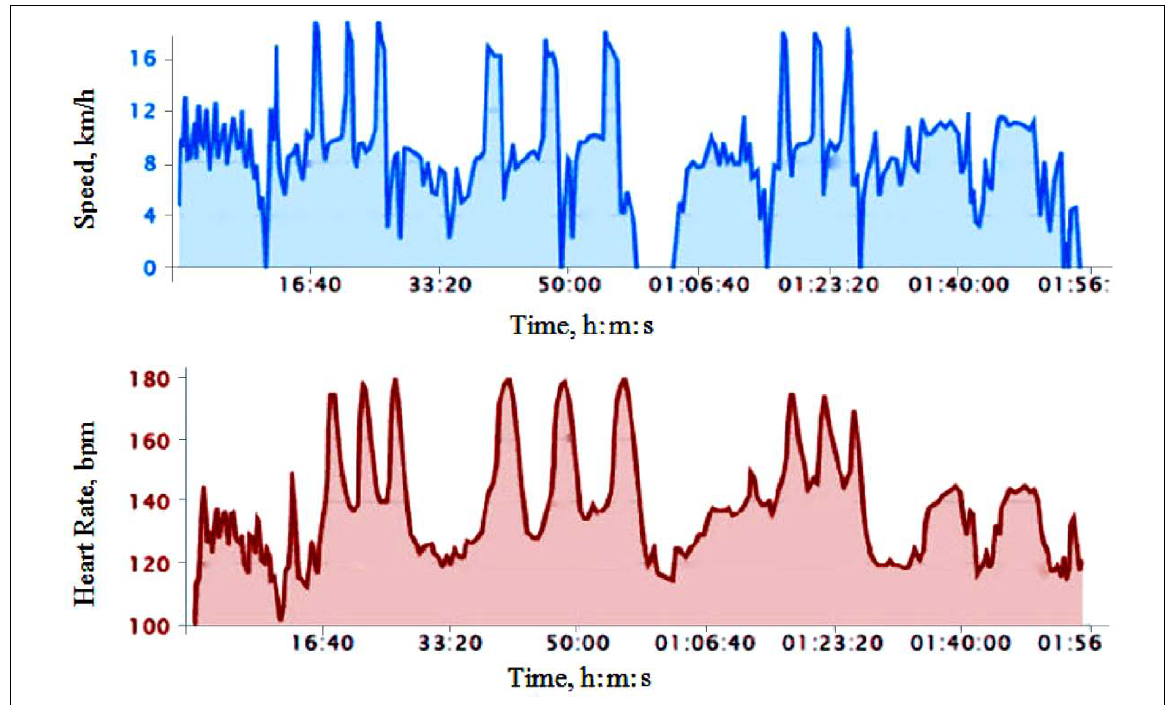
Figure. Distance, overcome by kayak rower R. N., and the change of boat pace and pulse rate in one training